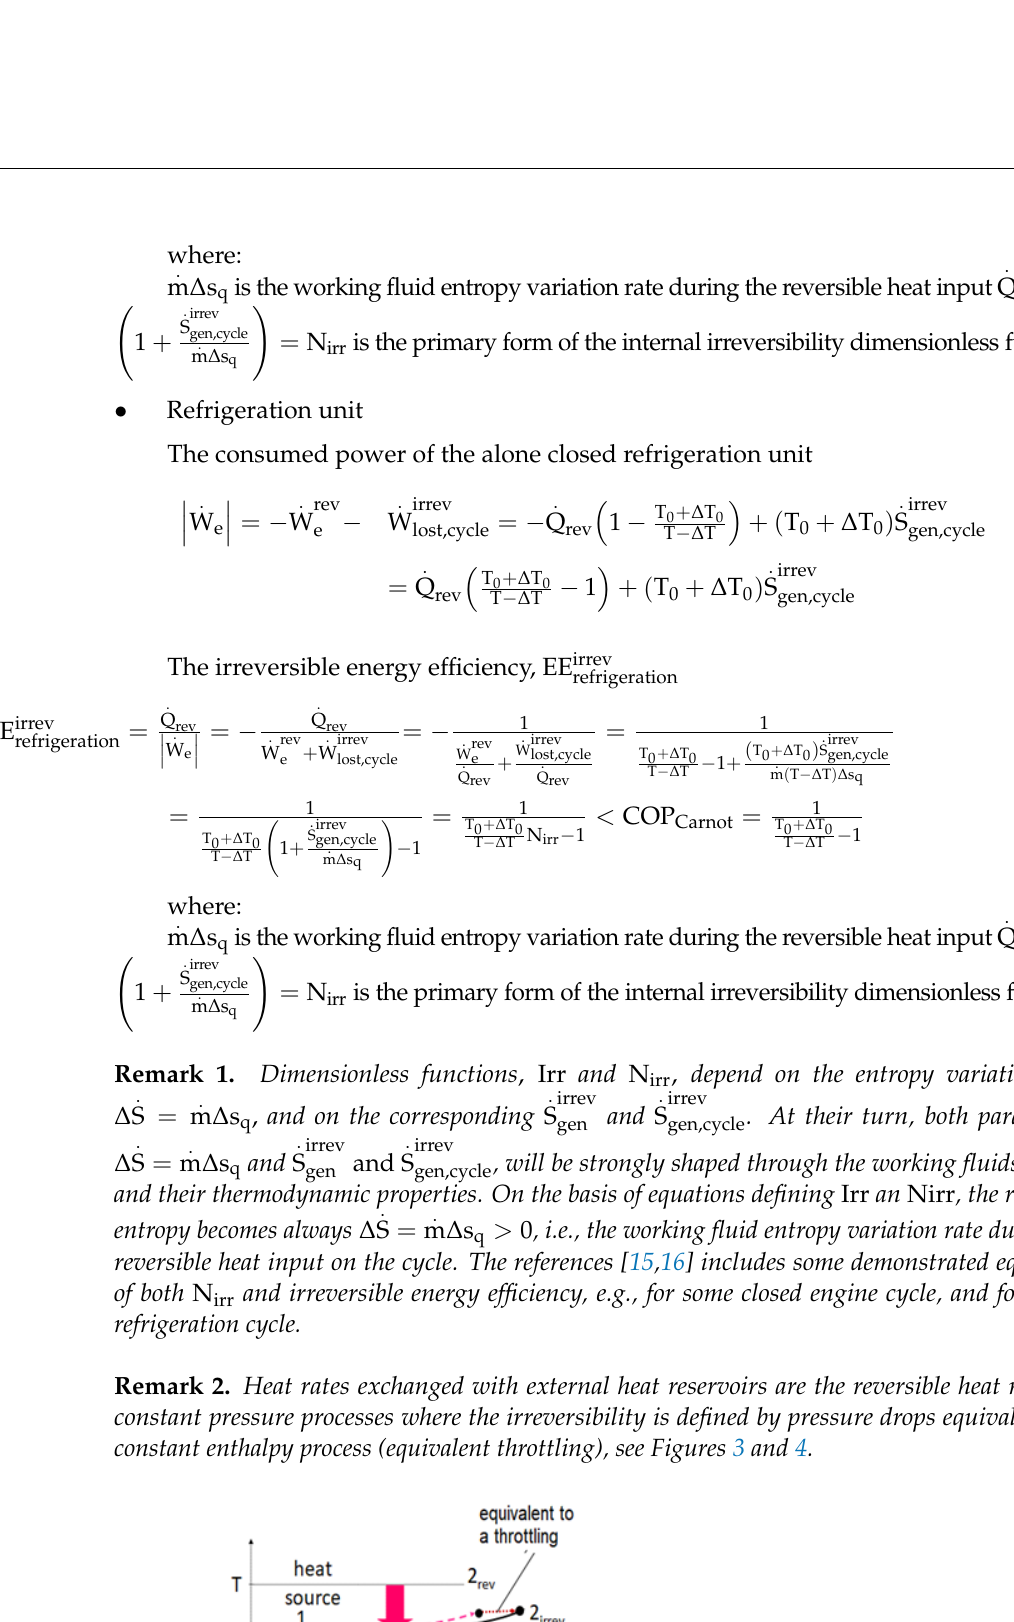
Figure 4. Irreversible heat output is equalizing the reversible one, constant pressure cooling. When we have different irreversible non adiabatic processes, e.g., constant tempera- ture, polytropic, constant volume we have to define the irreversibility either through ad- equate and known pressure drops caused by friction or through irreversible lost work alike it is defined the isentropic efficiency of an adiabatic process. Remark 3. Reversible entropy variation during the heat output can be evaluated through the num- ber of internal irreversibility, N irr , i.e., ∆S(cid:4662) (cid:2868) = m(cid:4662) ∆s (cid:2927)(cid:2868) = −N (cid:2919)(cid:2928)(cid:2928) ∆S(cid:4662) = −N (cid:2919)(cid:2928)(cid:2928) m(cid:4662) ∆s (cid:2927) . Knowing the re- versible cyclic heat input and heat output they can be assessed the irreversible power and the irre- versible energy efficiency. 3. Design Imposed Operational Conditions The first design of irreversible cycles can be performed using four imposed condi- tions see for instance [19]. These operational imposed conditions might be also combined, for instance constant specific power and constant energy efficiency for engines and con- stant heat input and constant energy efficiency for refrigeration units. The analysis and design of irreversible cycles has always two directions. The first one is to analyze the cycle ignoring the energy interactions with the environment, see Section 3.1 below. The second one uses the energy interactions as main control functions and takes into consideration only the number of internal irreversibility as a general internal function quantifying the all internal irreversibility and linking the external heat transfers with ex- ternal heat reservoirs, see the following Section 4. 3.1. FPDT Internal Design through Imposed Operational Conditions They have to define the internal main finite physical dimension parameters and after that to establish the dependence functions characterizing the performances of the irre- versible cycle. For instance, [19] applied the four imposed operational conditions to eval- uate the performances of a Joule-Brayton cycle working with two ideal gases, air and CO 2 . The main finite physical dimension parameter was the classical compression ratio, π C , and the dependence functions characterizing the performances of the irreversible cycle were: • the maximum temperature on the cycle, T 3irr [K], see Figure 5,